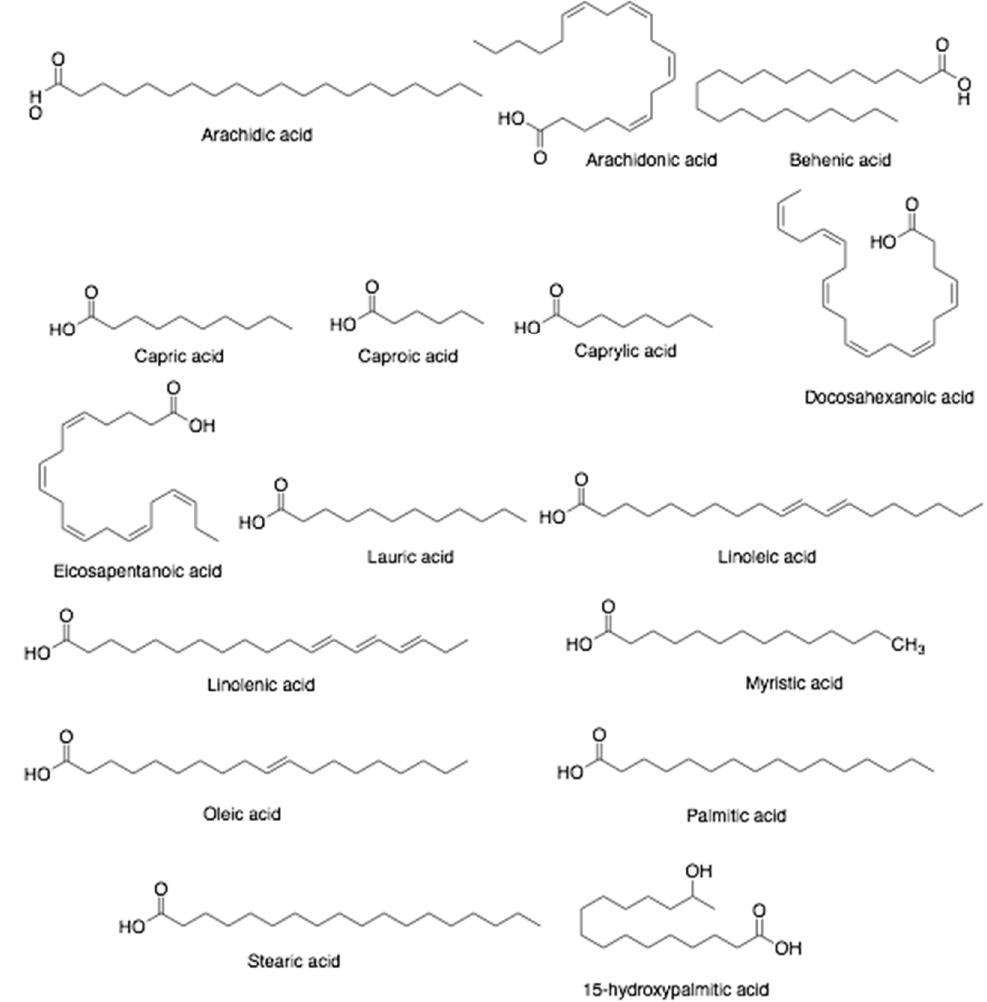
Figure 8. Chemical structures of fatty acids found in bee products, including bee bread.